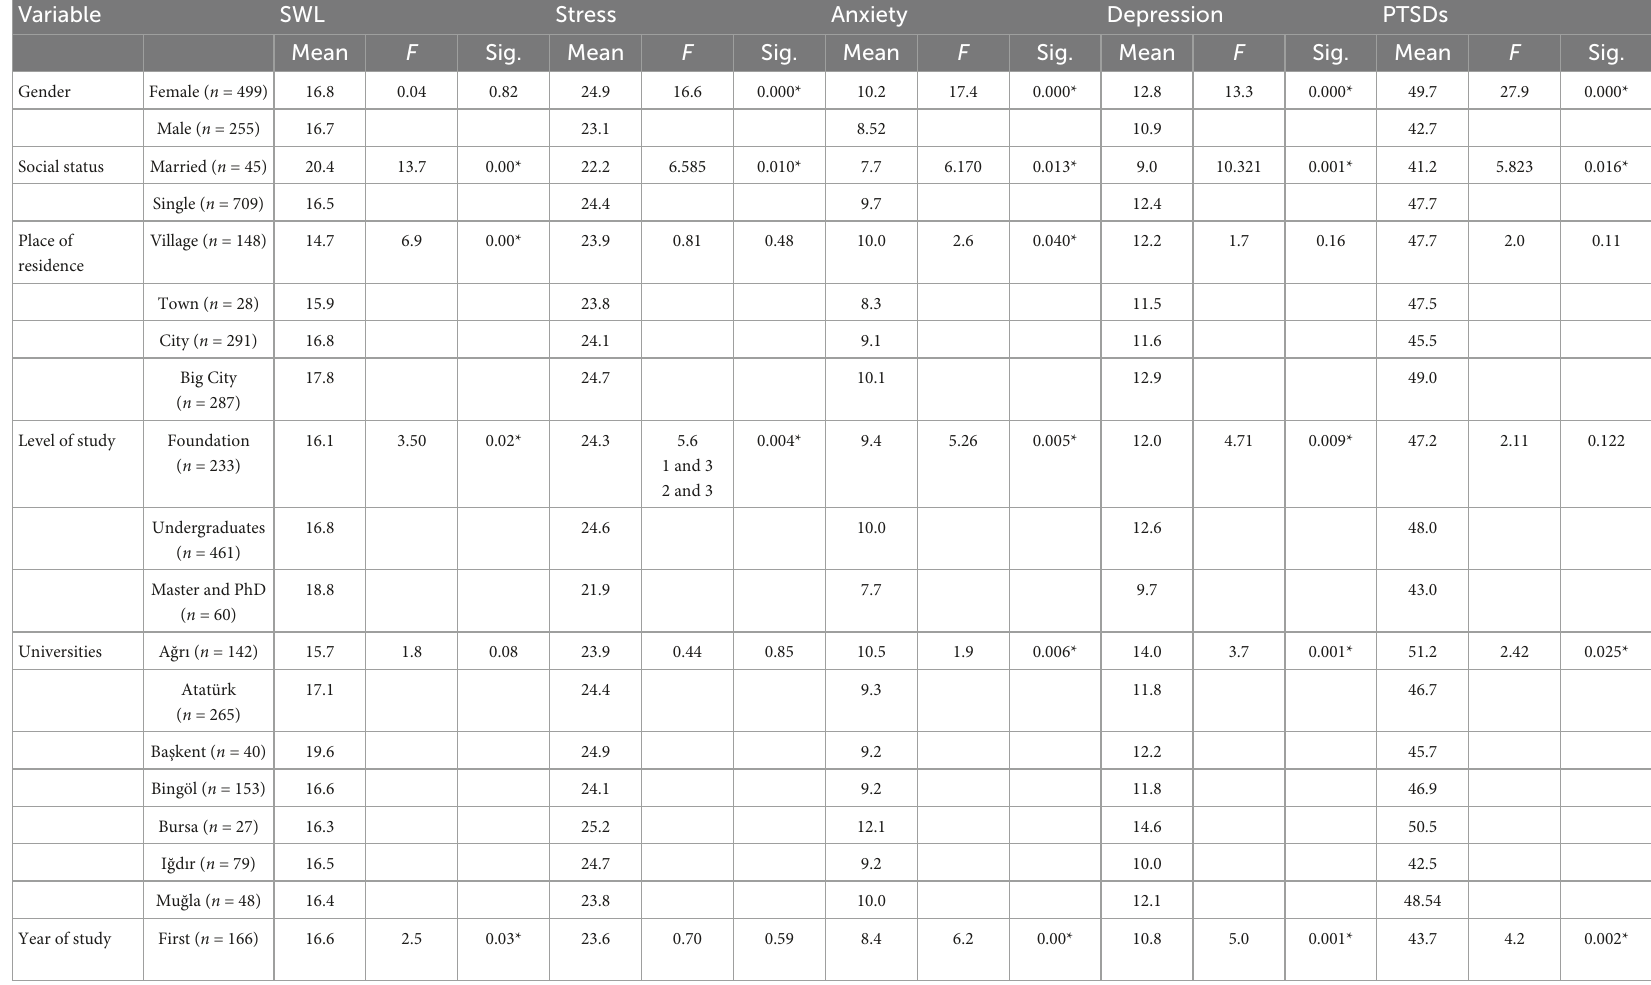
TABLE 4 Significant differences according to demographic variables and exposure to COVID-19 items. Variable SWL Stress Anxiety Depression PTSDs